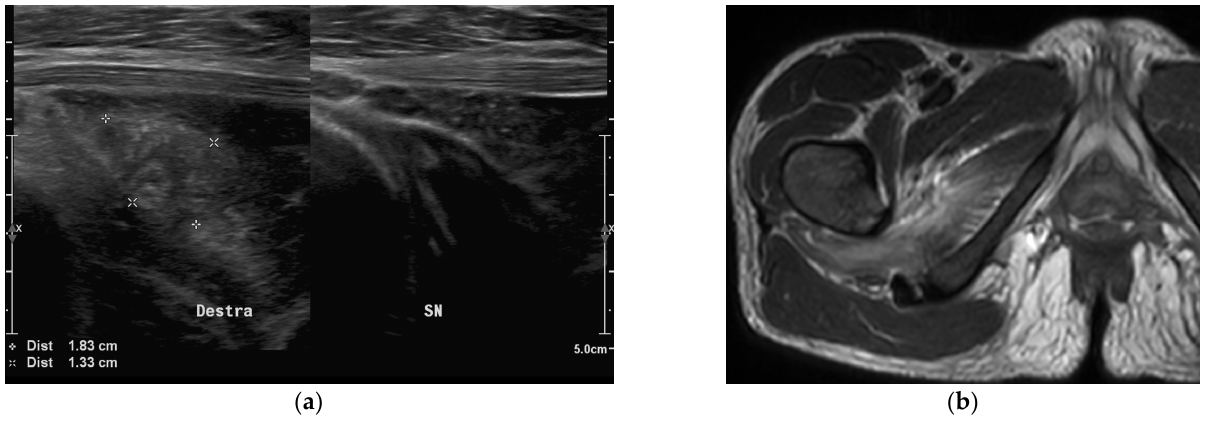
Figure 2. Pyomyositis of the quadratus femoris muscle in a 15-year-old girl affected by end-stage renal disease. ( a ) Soft tissue ultrasound shows enlargement and inhomogeneous hyperechogenic texture of the right muscle, compared to the healthy contralateral muscle. ( b ) Axial T2-weighted MR image shows hyperintense signal in the muscle, no bone or joint involvement.